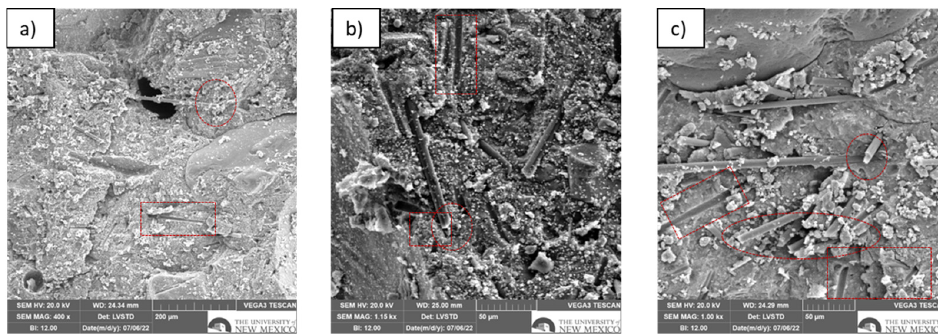
Figure 15. SEM images of sample ( a ) chopped (CH2), ( b ) milled (M2), and ( c ) hybrid mix (H2). Circular marks indicate signs of fiber rupture. Rectangular marks indicate signs of fiber pull-out.